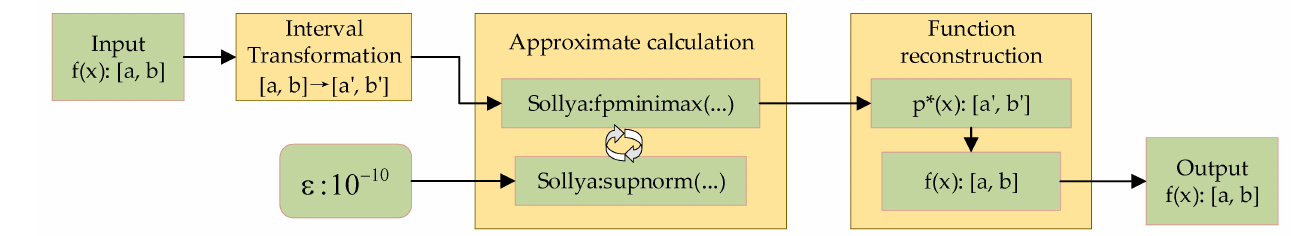
Figure 2. Implementation Framework of Single-Precision Activation Function